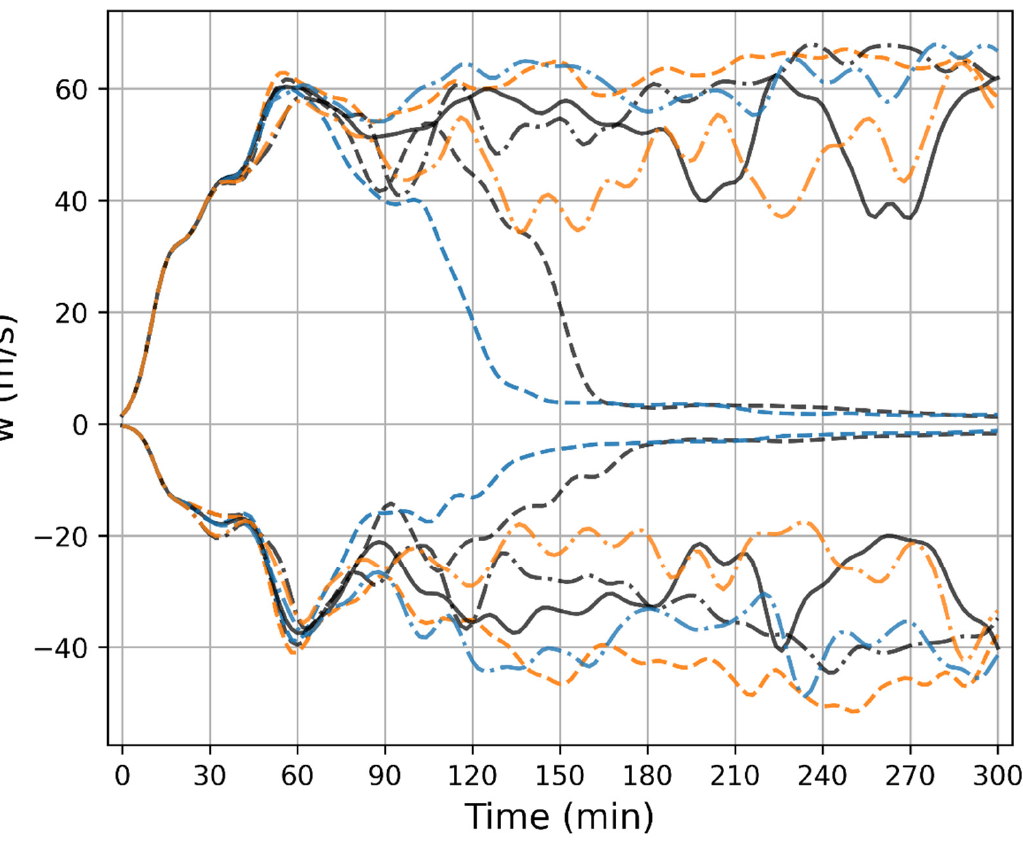
Figure 5. The temporally smoothed domain maximum updrafts (positive values) and downdrafts (negative values). The colors and styles of curves representing different cases are the same as in Figure 4.